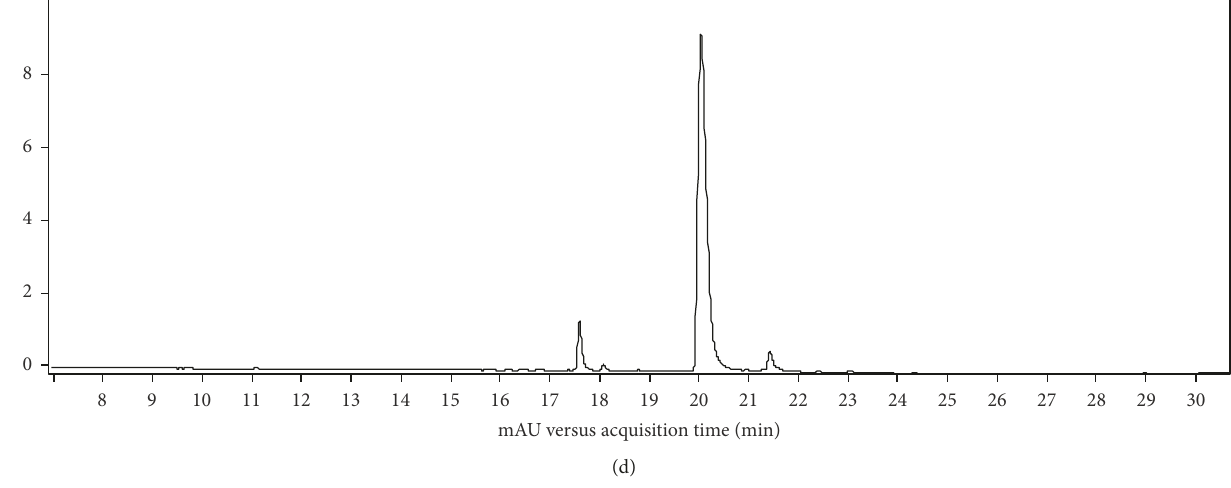
Figure 1: (a) Total ion chromatogram obtained by GC-QTOF-MS, (b) base peak chromatogram in the positive ionization mode, (c) chromatograms at 280 nm, and (d) 450 nm of the alkaloid extract obtained by RP-UHPLC–DAD–QTOF-MS. Compounds are numbered according to Table 2: (1) pallidine; (2) isoboldine derivative; (3) N,N -dimethylcoclaurine (4) fumaritine; (5) coclaurine; (6) N - methylcoclaurine; (7) magnoflorine; (8) reticuline; (9) parfumine; (10) parfumidine; (11) isoboldine; (12) coreximine; (13) methylcoreximine 1; (14) methylcoreximine 2; (15) cheilanthifoline; (16) dehydrocheilanthifoline; (17) demethyleneberberine/jatrorubine; (18) cryptopine; (19) protopine; (20) fumariline; (21) stylopine; (22) coptisine; (23) corysamine; (24) impatien C; (25) dihydrosanguinarine; (26) 8-oxocoptisine. 1 󸀠 –6 󸀠 unknown